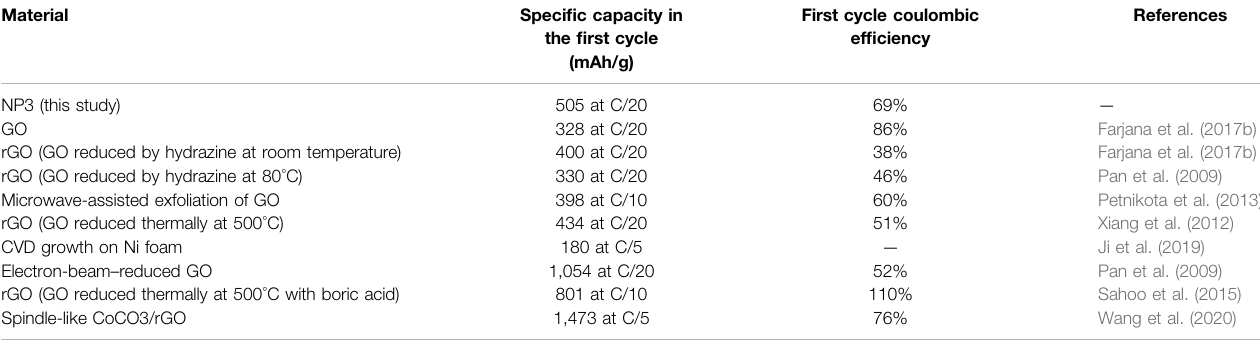
TABLE 3 | Summary of the electrochemical behavior of previously reported graphene-based anode materials.